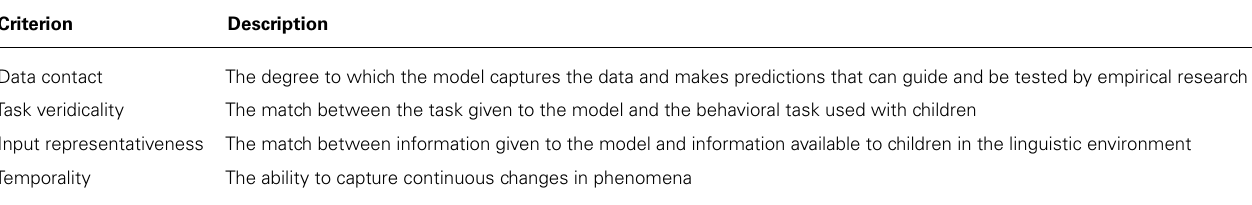
Table 1 |The four criteria used to assess computational models of early word learning in the current